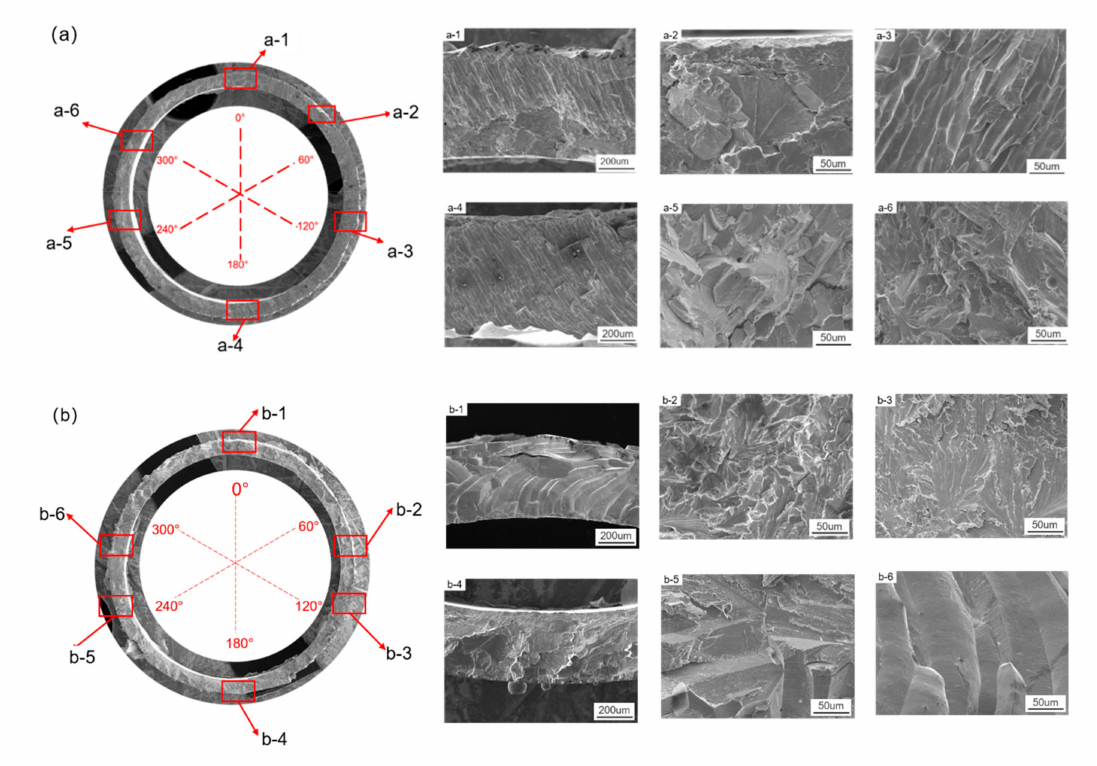
Figure 15. Fracture surface morphologies by SEM of NS Mo alloy laser welding joints under heat input of: ( a ) 250 J / cm; ( b ) 3600 J /